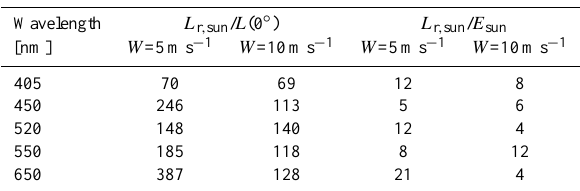
Table 4. Relative RMS error of estimates in % by two different normalizations.